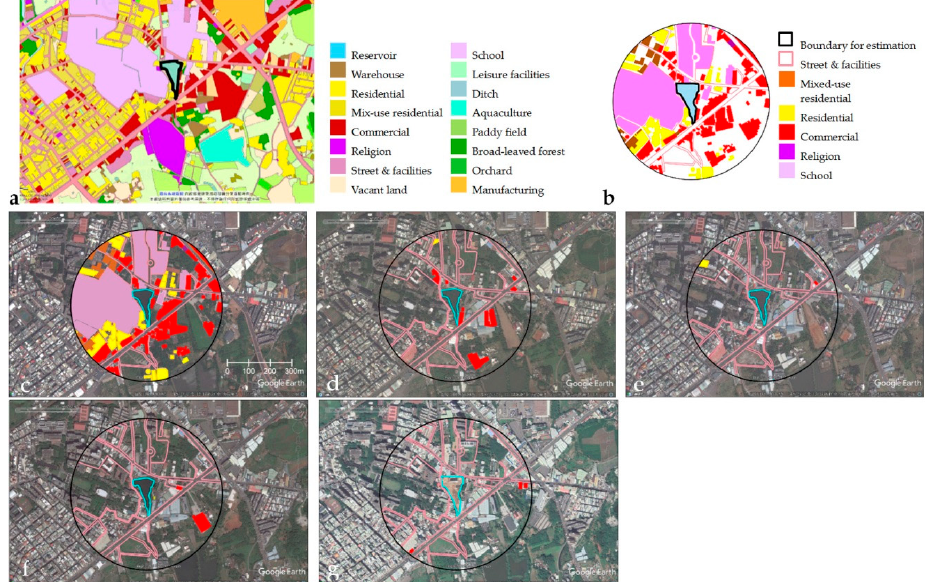
Figure 10. Land use districts ( a ) and building types ( b ) around Chung Yuan Eco Pond Park; highlighted area of modifications made in ( c ) 2010, ( d ) 2013, ( e ) 2014, ( f ) 2016, and ( g ) 2018.